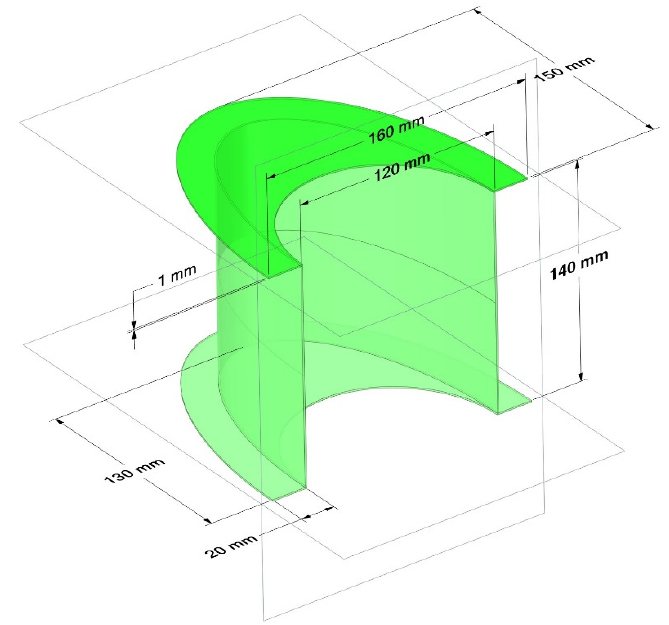
Figure 4. Novel Blade profile: A2-B3-C4-D4-Ex.